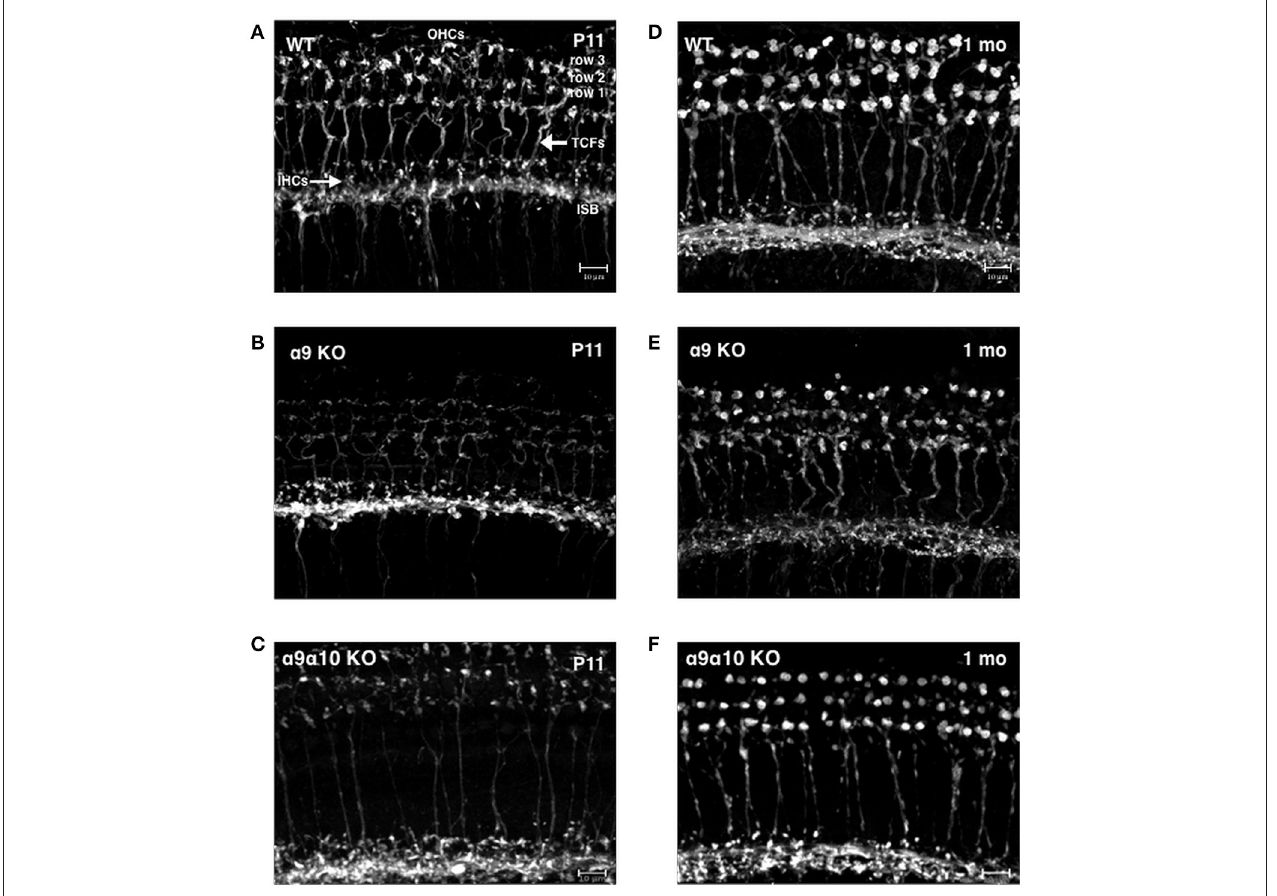
FIGURE 12 | Confocal projections of cholinergic innervation patterns from middle regions (15–20 kHz) of the mouse cochlea. (A) In the wildtype (WT) animal at P11, ChAT-labeled efferent fibers and terminals are found below inner hair cells (IHCs) and in the inner spiral bundle (ISB). Thick ChAT-labeled efferent fibers cross the tunnel of Corti (TCFs) and terminals contact outer hair cells (OHCs) in rows 1, 2, and 3. (B) In the α 9 KO mutant at P11, ChAT-labeling is more robust below IHCs but more sparse below OHCs. Very thin ChAT-labeled efferent fibers are seen crossing the tunnel of Corti. (C) In the α 9 α 10 KO mutant at P11, ChAT-labeling is more robust below IHCs but more sparse below OHCs. Very thin ChAT-labeled efferent fibers are seen crossing the tunnel of Corti. (D) In the WT at 1 month, ChAT-labeling is found below IHCs in the ISB and large terminal clusters are seen on OHCs. ChAT-labeled efferent fibers cross the tunnel of Corti. (E) In the α 9 KO mutant at 1 month, ChAT-labeling is found below IHCs. Thick ChAT-labeled efferent fibers cross the tunnel of Corti. Compared to WT, ChAT-labeled OHC terminal clusters are smaller with smaller individual terminals. (F) In the α 9 α 10 KO mutant at 1 month, the ISB has ChAT-labeled fibers and terminals below IHCs OHC terminal clusters are smaller than WT but have larger individual terminals than in the α 9 KO. ChAT-labeled efferent fibers cross the tunnel of